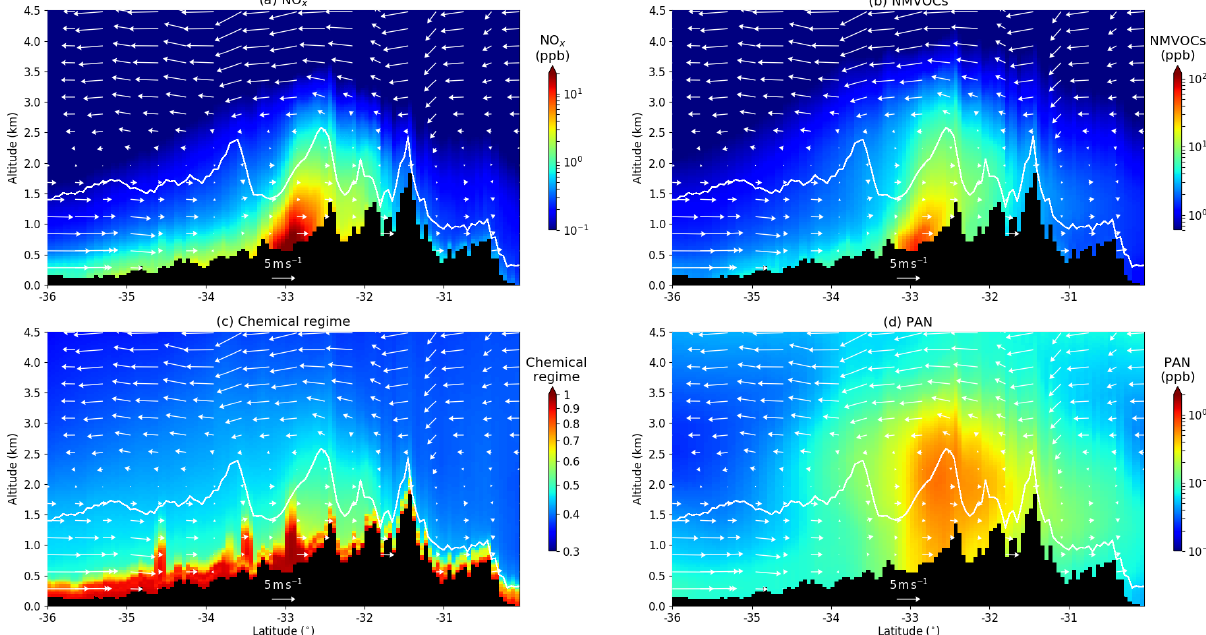
Figure A5. (a) Simulated NO x concentrations (color map), wind (arrows), afternoon boundary layer (white solid line), and terrain elevation (black area) along the summertime transect considered in Fig. 9a, showing the average for summertime in 2015. Panel (b) is the same as panel (a) for NMVOC. Panel (c) is the same as panel (a) for chemical regime. Panel (d) is the same as panel (a) for peroxyacetyl nitrate